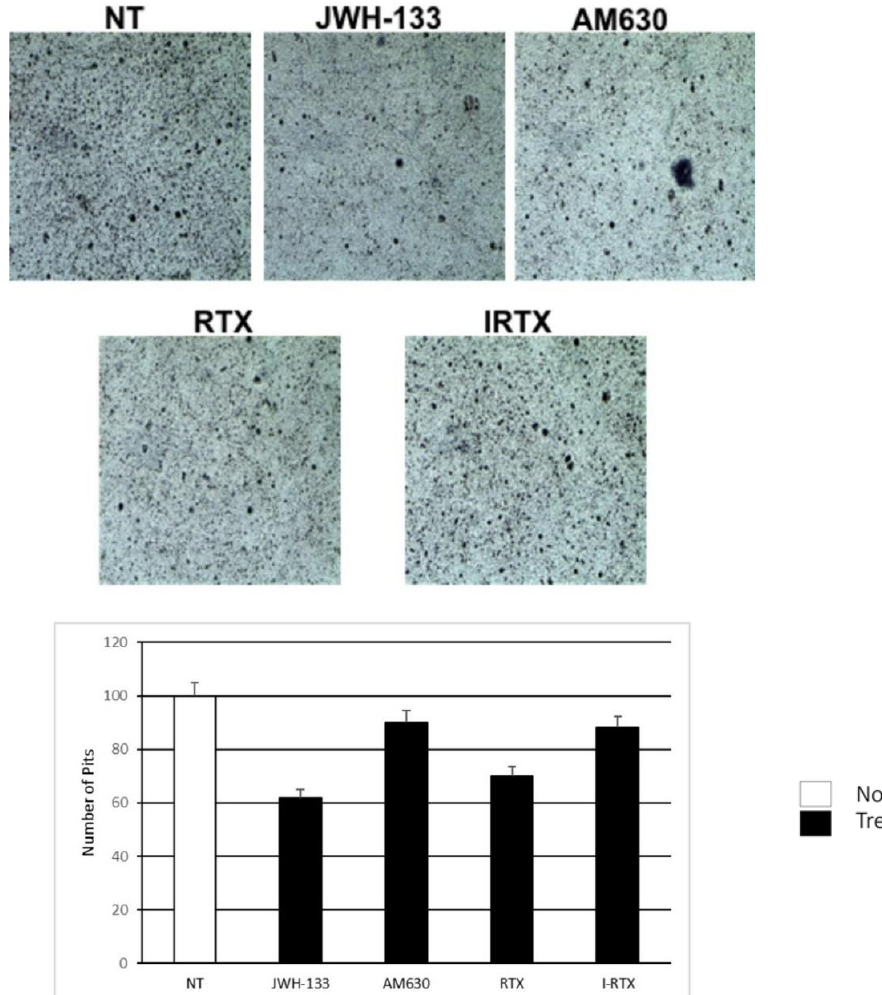
Figure 7. Comparison of bone resorption assay, performed on 2 OCs of patients with PBD, in the untreated (NT), JWH-133 AM630, RTX and IRTX treated samples. The most representative images are displayed. The percentage number of reabsorption pits is presented in histograms as mean ± SD.